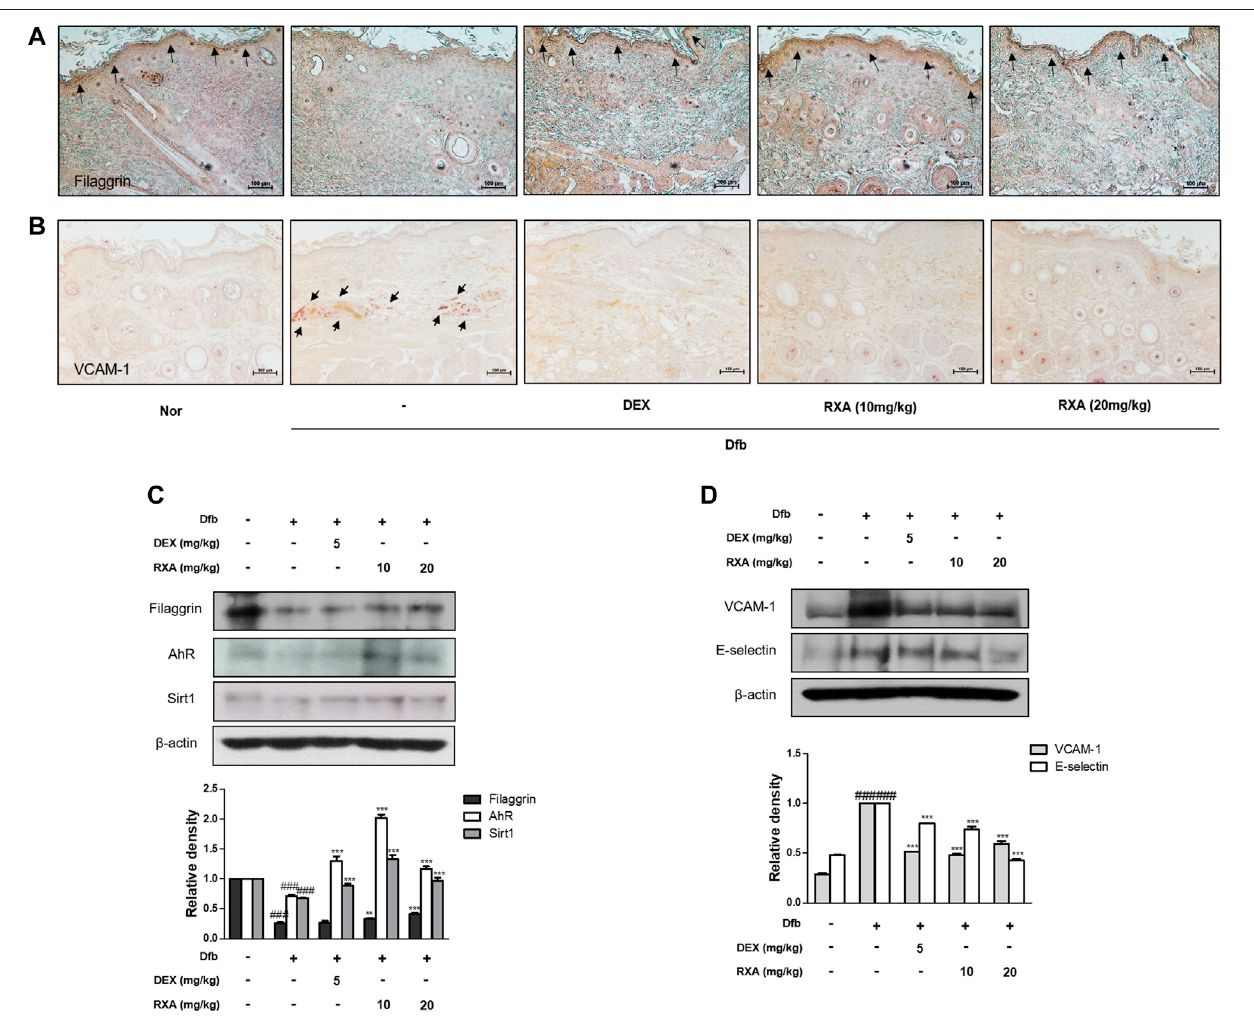
FIGURE 4 | Effects of RXA on the expression of fi laggrin, SIRT1, AhR, and adhesion molecules in Dfb-induced NC/Nga mice. Skin sections were stained with immunohistochemical staining. Dexamethasone (5 mg/kg, DEX) was used as the positive control. (A) Filaggrin in stratum corneum of epidermis and (B) VCAM-1 in dermis of the mouse skin were detected using speci fi c antibodies. Black arrows indicate stained regions (scale bar (cid:1) 100 μ m). Total proteins were prepared and analyzedbyWesternblottingtechniquefor (C) fi laggrin,AhR,SIRT1and (D) adhesionmolecules,usingspeci fi cantibodies. β -actinwasusedastheinternalcontrol. Thedatashownrepresent mean ± S.D.ofthreeindependent experiments( n (cid:1) 8). ### p < 0.001vs.thecontrolgroup;** p < 0.01,*** p < 0.001vs.Dfb-treatedgroup.Dfb, Dermatophagoides farinae body; AhR, aryl hydrocarbon receptor; SIRT1, sirtuin1.